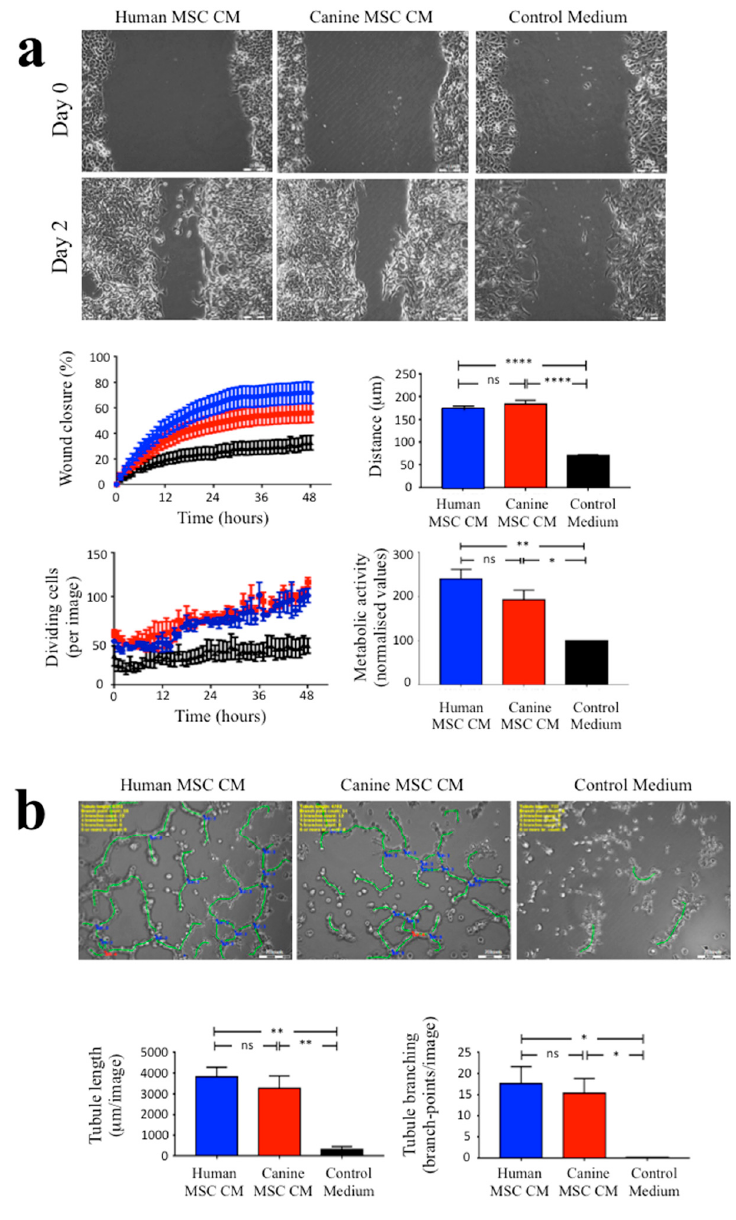
Figure 3. Human and canine MSC conditioned medium increased EA.hy926 endothelial cell migration and proliferation and induced the formation of endothelial tubule-like structures in Matrigel assays. ( a ) Representative images are shown under phase-contrast microscopy of EA.hy926 endothelial cell scratch wound assays. Image analysis of digitized images collected every 15 min over a two-day period demonstrated that scratch wound closure and endothelial cell migration was markedly greater in the presence of human and canine MSC CM versus control medium, with no significant difference seen between human and canine MSC CM (top graphs). Further image analysis (left lower panel) showed a significant increase in the numbers of dividing EA.hy926 cells in the presence of human and canine MSC CM compared to the control medium. In addition, there was increased metabolic activity in MSC CM treated cultures compared to control cultures (lower right panel). Scale bars = 200 μ m. ( b ) Representative phase-contrast images are shown of EA.hy926 endothelial cells cultured on Matrigel in the presence of human MSC CM or canine MSC CM versus control medium. (Bottom panels) Significant increases were observed in both the total endothelial tubule length (per image) and the total number of endothelial branch points in EA.hy926 cultures